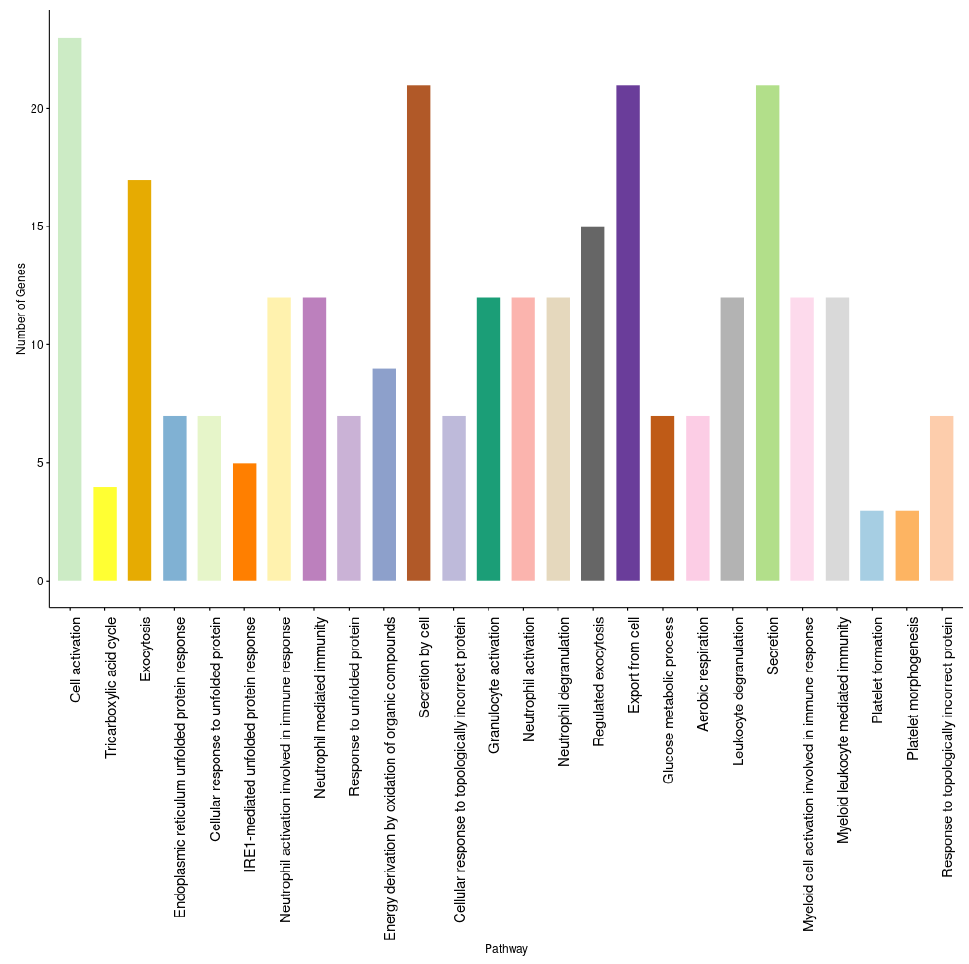
Figure 7. The enrichment analysis of diabetes-related genes in gene expression analysis.